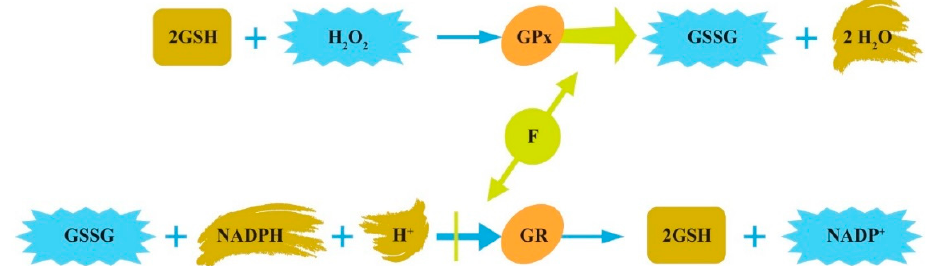
Figure 3. The glutathione redox system. Glutathione (GSH), a radical scavenger, is converted to oxidized glutathione (GSSG) through GSH peroxidase (GPx) and converted back to GSH by GSH reductase (GR). GSH can detoxify hydrogen peroxide (H 2 O 2 ), preventing the formation of free radical generation and lipid peroxidation products.